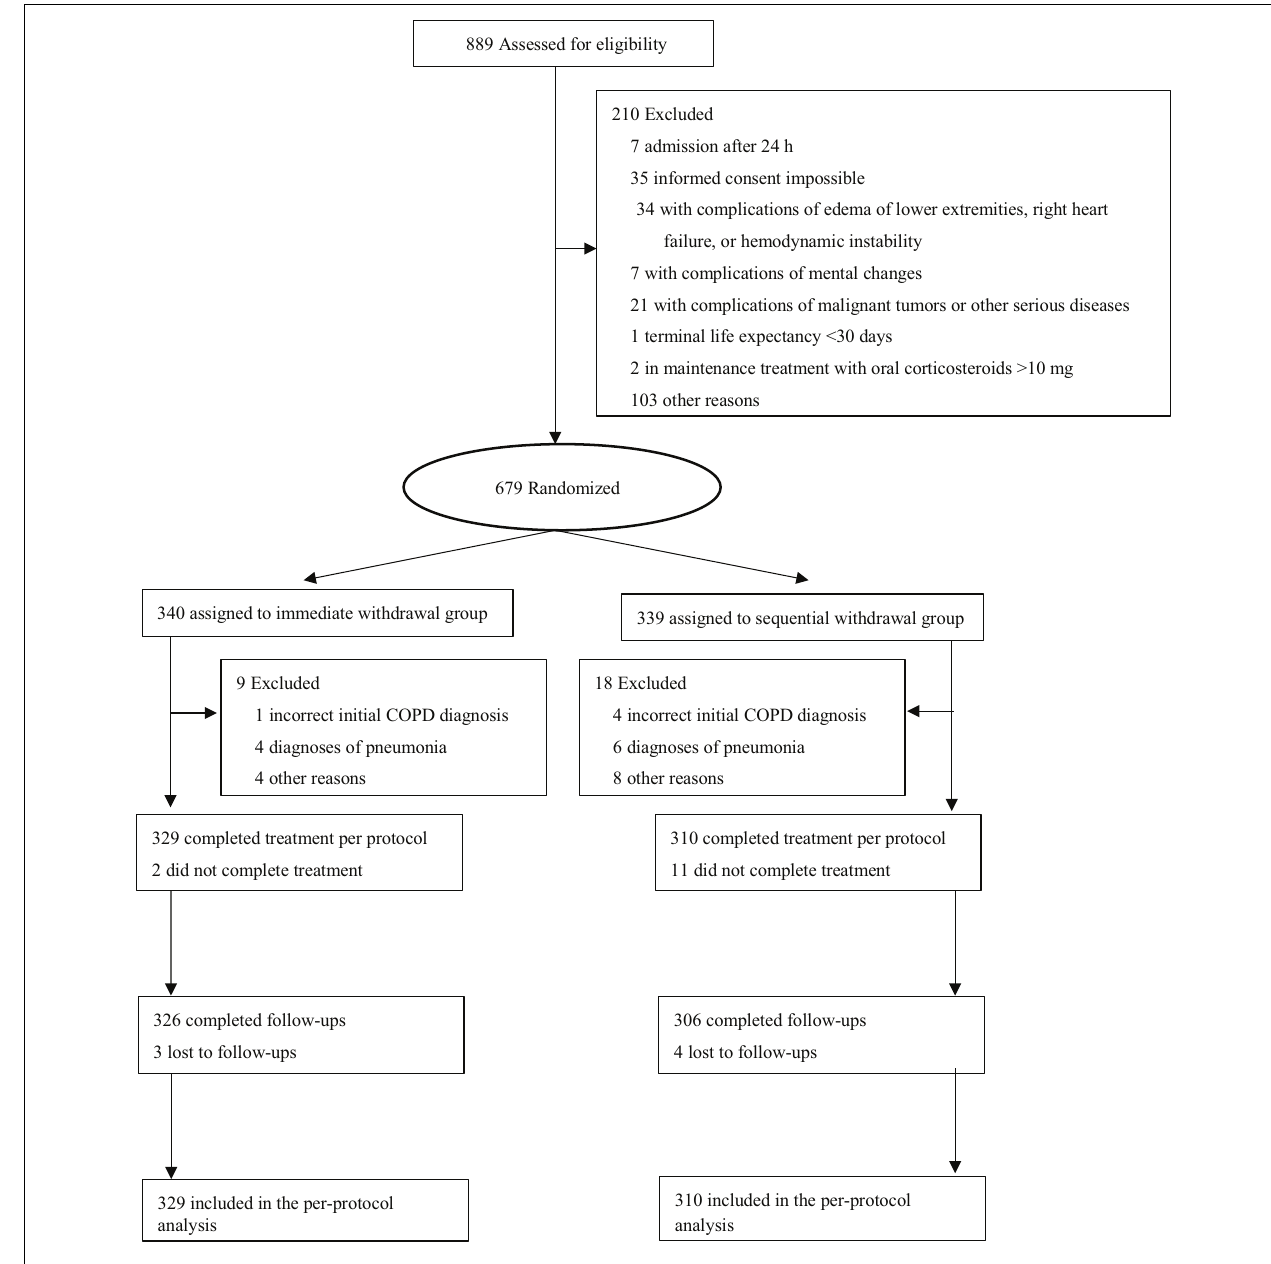
FIGURE 1 | Trial participant enrollment, assignment to immediate and sequential withdrawal groups, and inclusion in